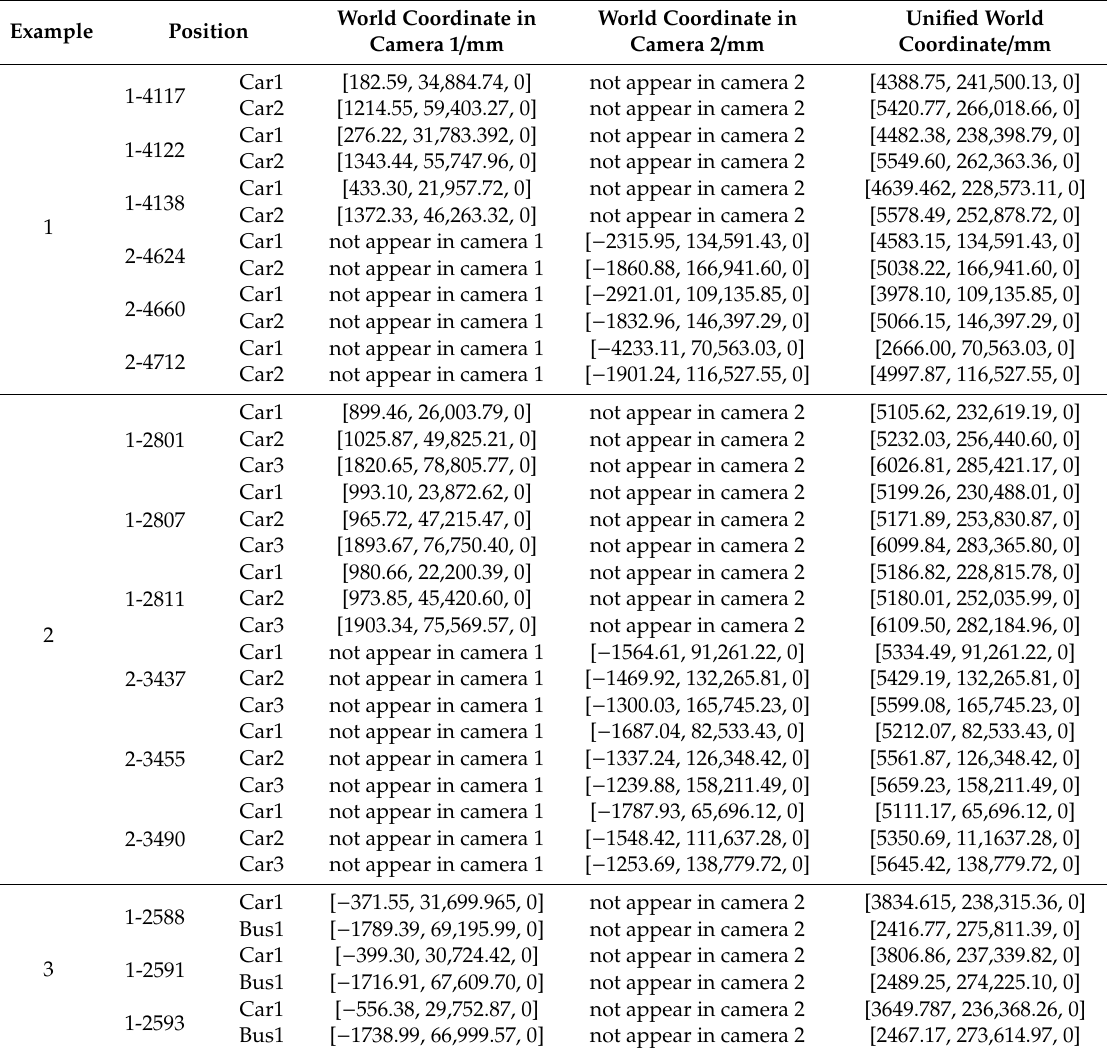
Figure 15. Examples of vehicle spatial distribution and 3D trajectory extraction in actual road scene. ( a ) Example 1; ( b ) Example 2; ( c ) Example 3. Table 7. Vehicle spatial distribution in actual road scene.